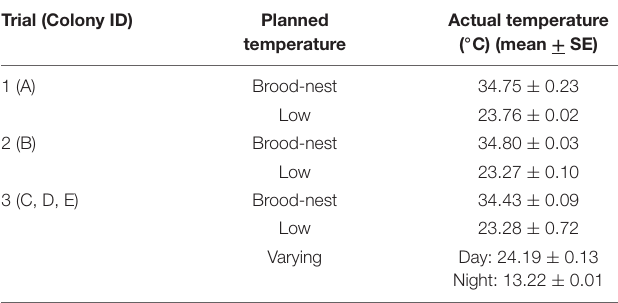
TABLE 1 | Recorded temperatures of one typical day (day 5) of the three trials.